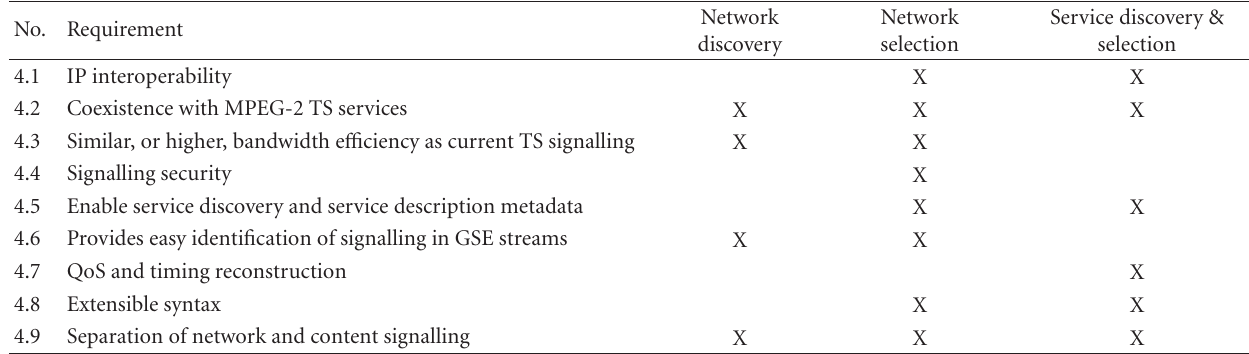
Table 1: Relationships among the proposal requirements and applicability to network/content discovery and